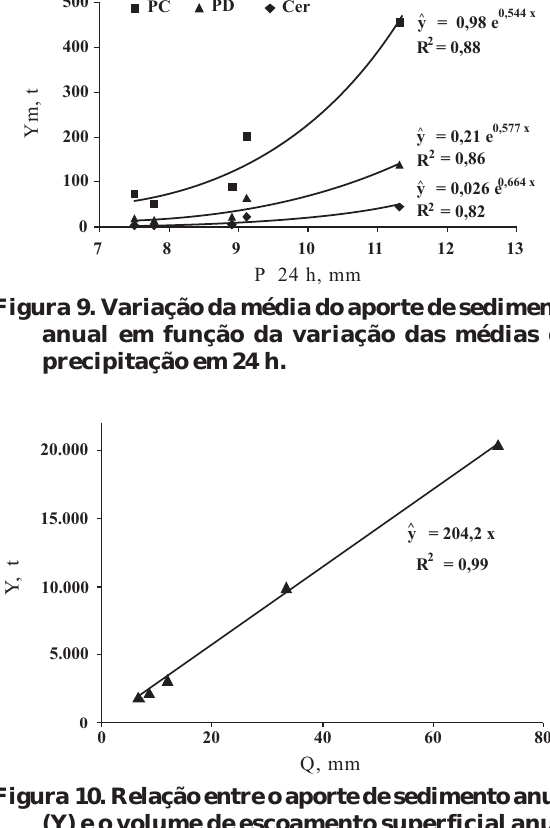
Figura 8. Relação entre o aporte de sedimento total anual (Y) e a precipitação pluvial anual (P